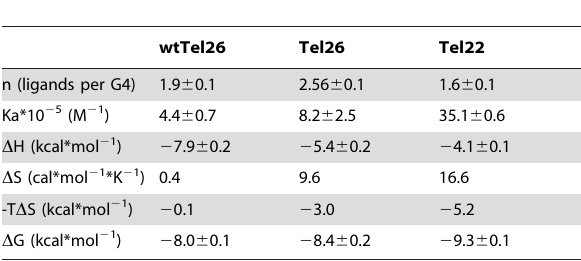
Table 1. Thermodynamic parameters derived from ITC titrations describing the interaction of (K34) 2 Ni(II) with Tel26